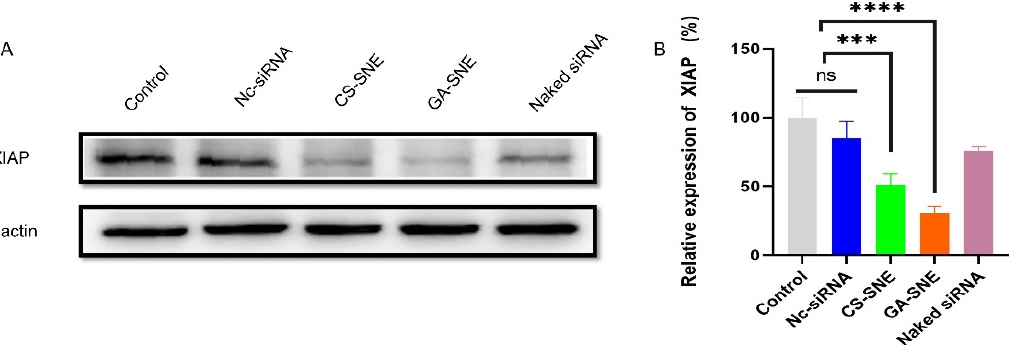
Figure 4. Effect of GA-CNE on XIAP protein expression. ( A ) Western blot analysis of XIAP protein in A549 cells treated with different formulations. ( B ) ImageJ quantification of the relative expression rate of XIAP protein in vitro (the value bars with ns are not significant, *** p < 0.001, **** p < 0.0001).